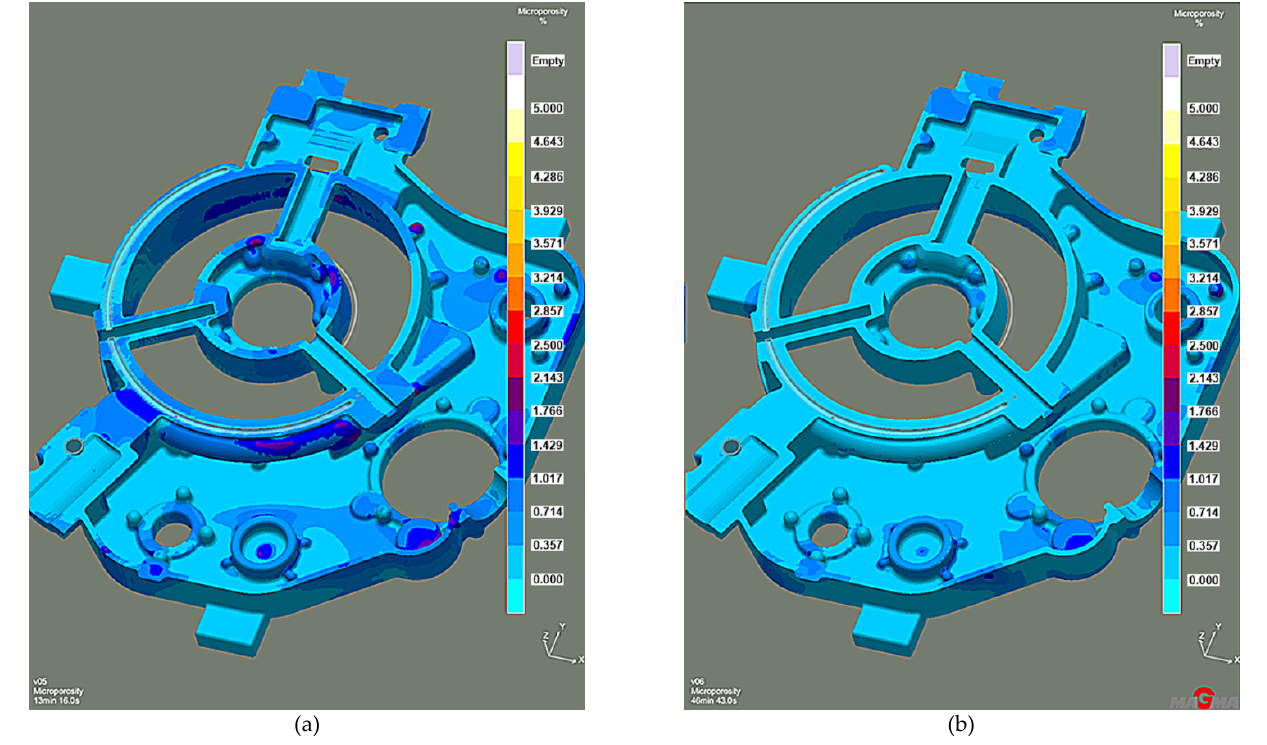
Figure 15. Stage 4 Microporosity criterion: ( a ) the system without feeding elements; ( b ) the system with top feeding risers.